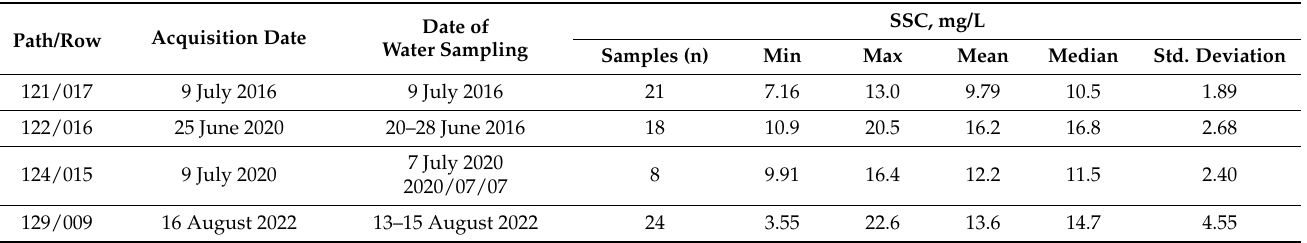
Table 3. Descriptive statistics associated with in situ SSC and Landsat satellite images used in the study for “Reflectance–SSC” model